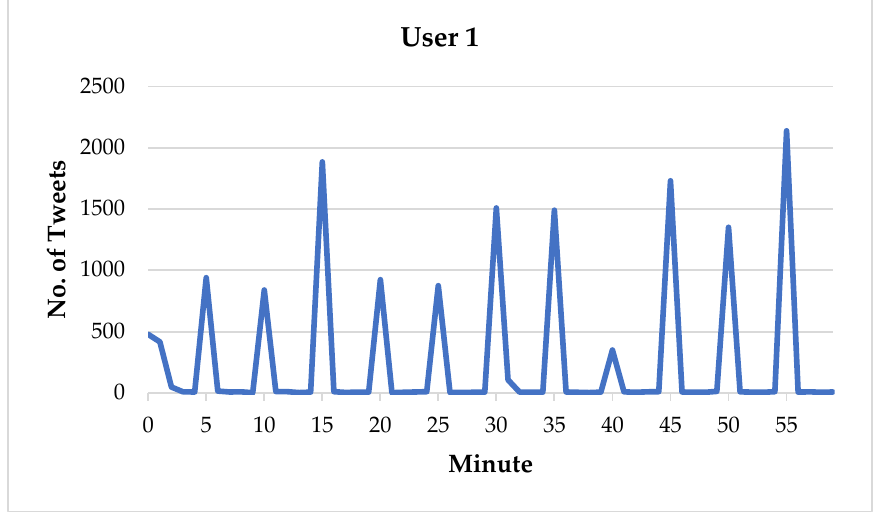
Figure 5. User 1’s frequency, with total tweets per minute over a one-hour Figure 5. User 1 ’ s frequency, with total tweets per minute over a one-hour period.